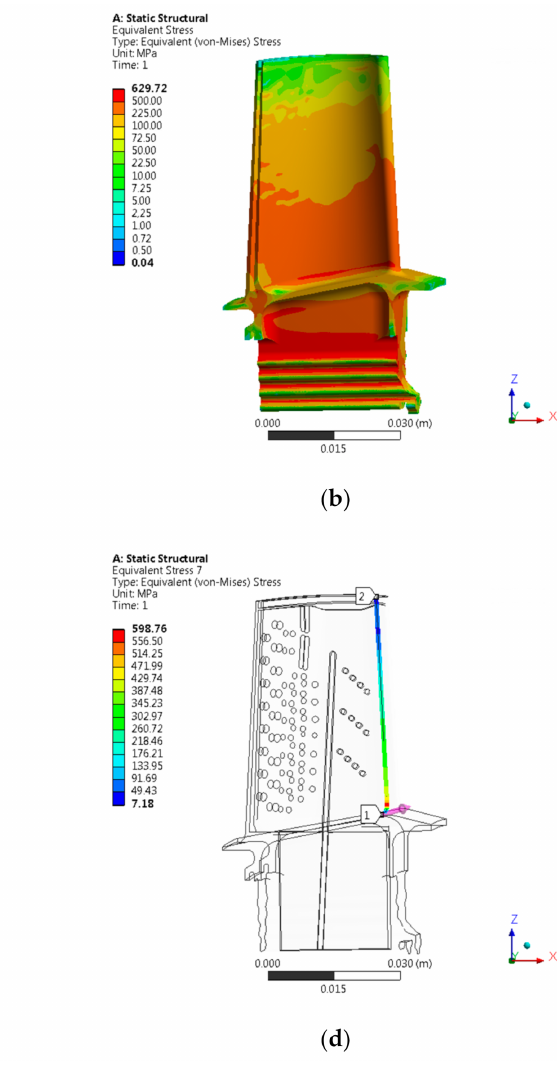
Figure 8. Results of HPT blade numerical analysis: ( a ) displacements [m], ( b ) equivalent stresses (von Mises) [MPa], ( c ) radial stresses [MPa], ( d ) equivalent stresses (von Mises) on blade leading edge [MPa].